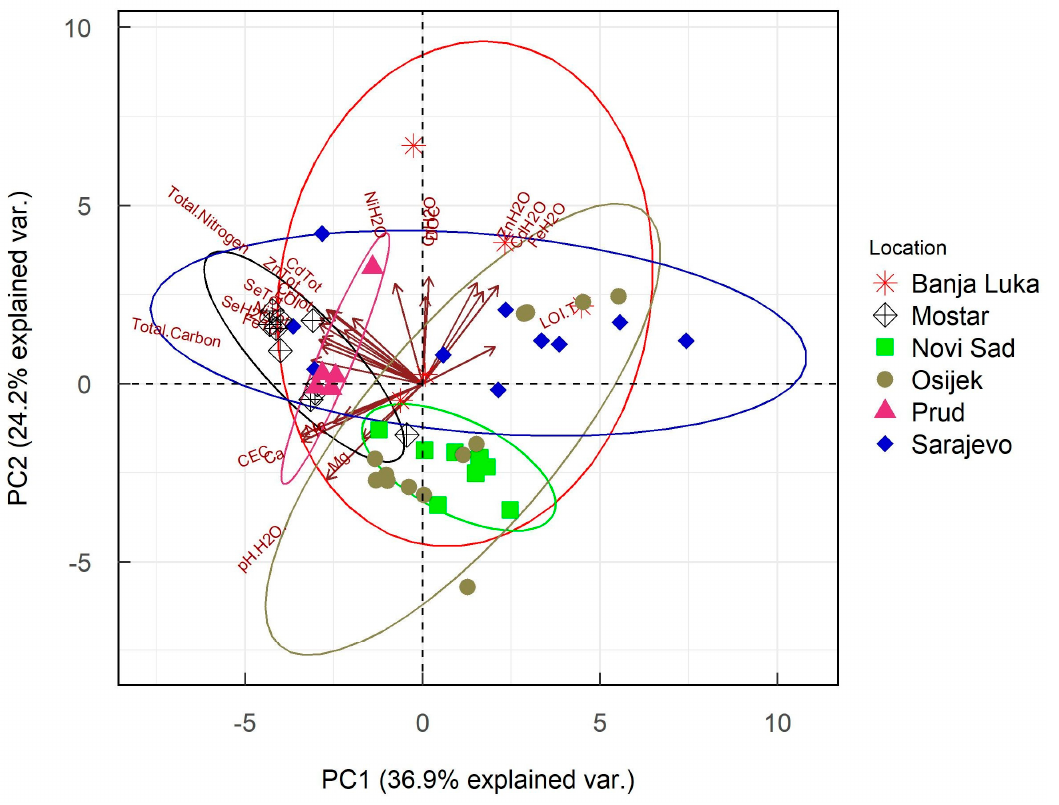
Figure 3. Biplot of principal components 1 and 2 from PC analysis of variation among six locations with di ff erent soil properties. Arrows represent the eigenvalues of each of the 24 selected soil parameters.